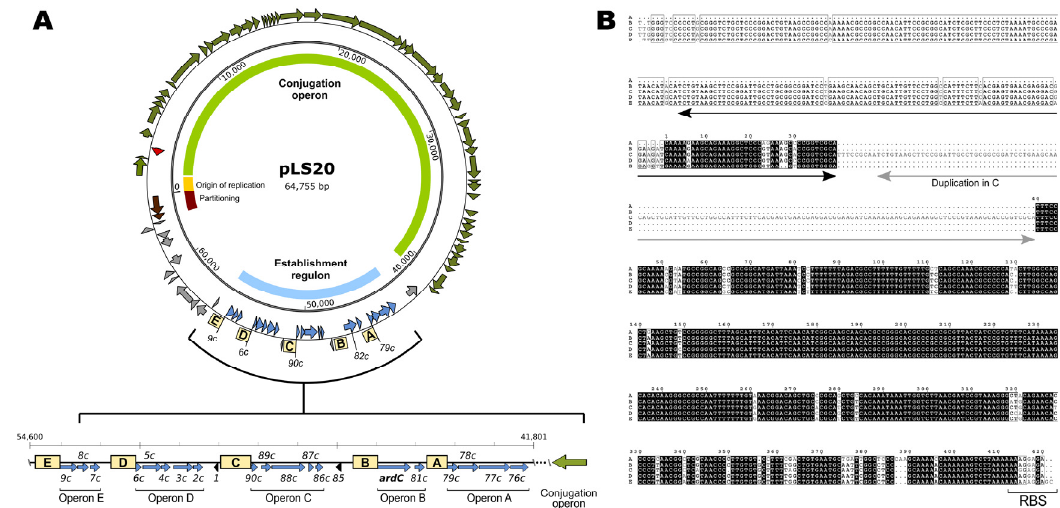
Figure 2. A conserved region of about 600 bp is present upstream of five putative operons on pLS20. ( A ) Circular map of pLS20. The different operons/modules are indicated with thick coloured lines on the inner circle: green, conjugation